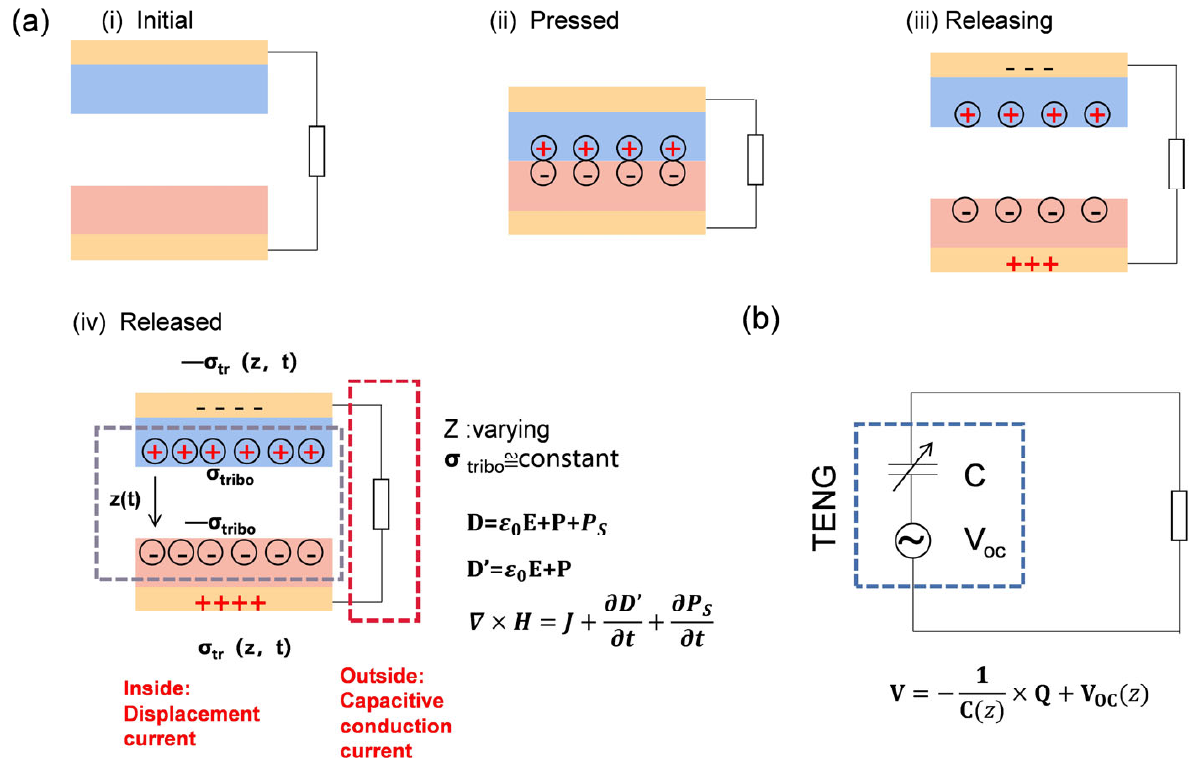
Figure 1. Theoretical models of TENG: ( a ) schematic illustration of the first TENG and its operation cycle. ( b ) The equivalent electrical circuit model of TENG.